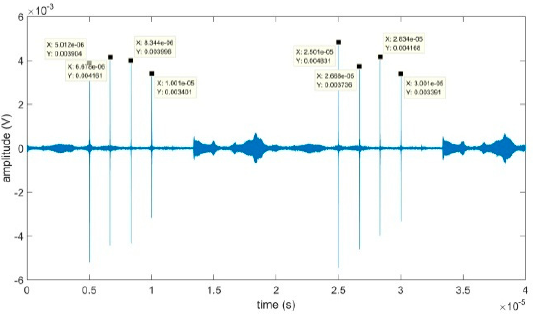
Figure 10. Experiment results with four input frequencies compressed by the SAW filter.